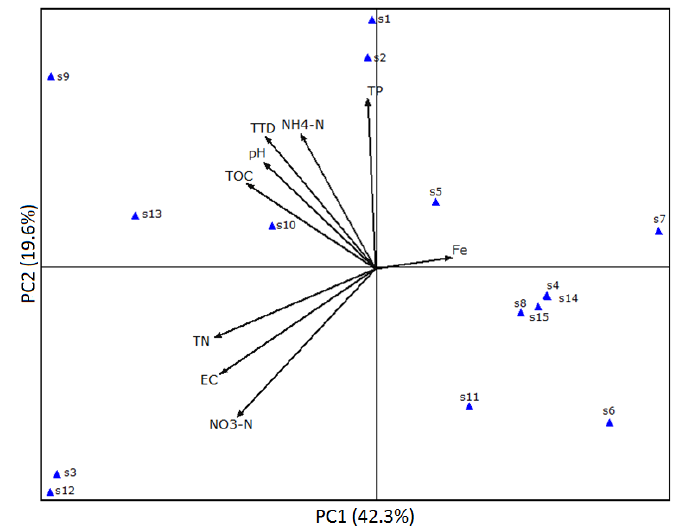
Figure 3. Principal component analysis of survival time ( ttd ) and water physicochemical properties. EC, electrical conductivity; TOC, total organic carbon; TN, total soluble nitrogen; TP, total soluble phosphorus; Fe, total soluble iron.